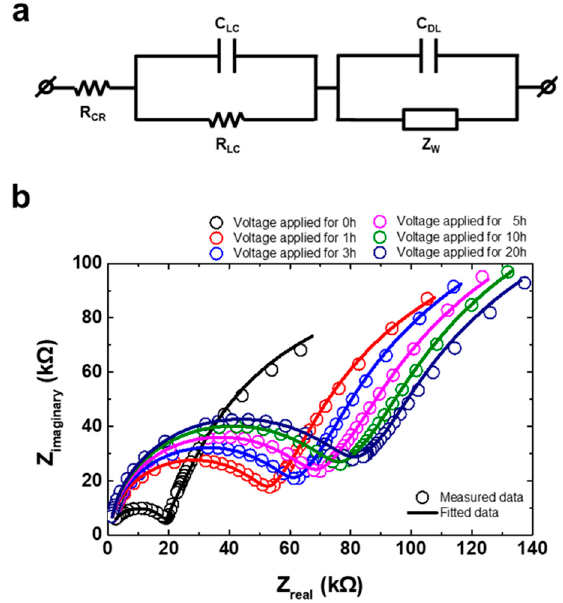
Figure 9. ( a ) Equivalent circuit model of the ion-doped LC cell and ( b ) its Nyquist plot as a function of time. The open circles and solid lines represent the measured and fitted results, respectively.